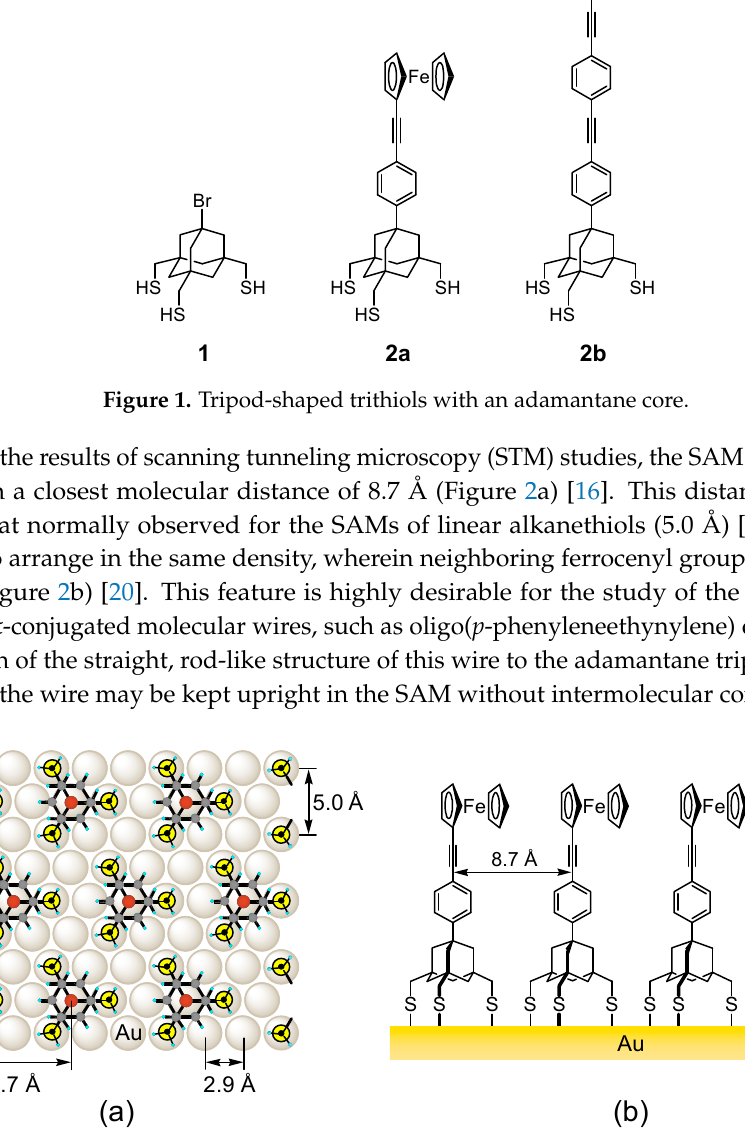
Figure 2. ( a ) Proposed molecular orientation of the SAMs of 1 on the Au(111) surface; and ( b ) the schematic diagram of the SAM of ferrocene-terminated trithiol 2a on a gold surface.